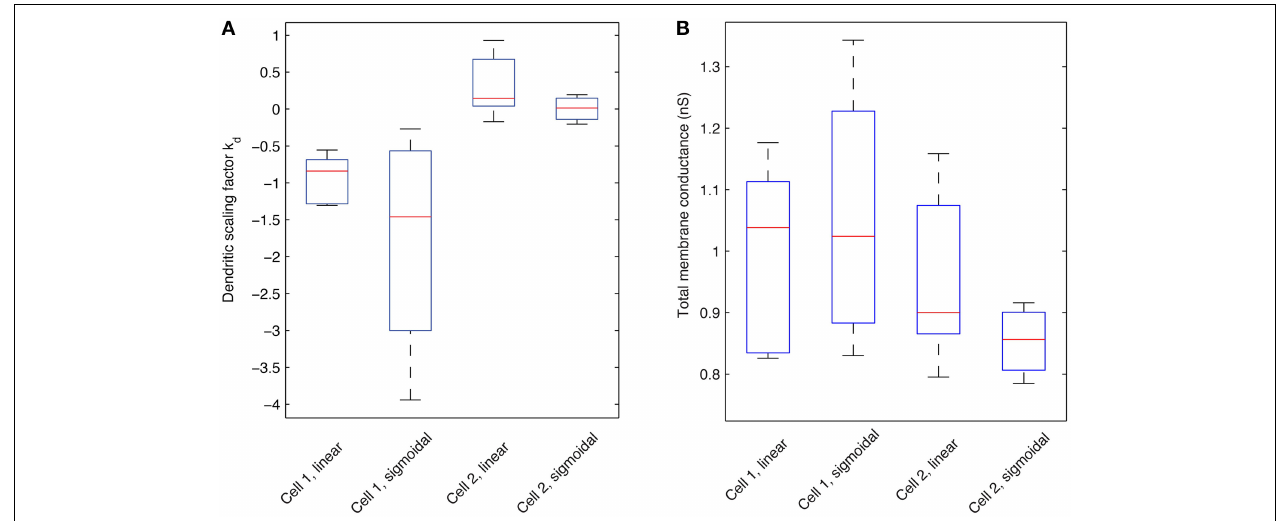
extremes of the k d values for each category. (B) Statistics pertaining to the total G h membrane conductance (in nS) of models with optimized R m , C m , t 1 , t 2 , ..., t 8 , and dendritic scaling factor k d for both linear and sigmoidal dendritic distribution for G h against both experimental traces used. Red lines indicate the median; box edges denote the 25th and 75th percentiles; whiskers extend to the extremes of the total G h values for each